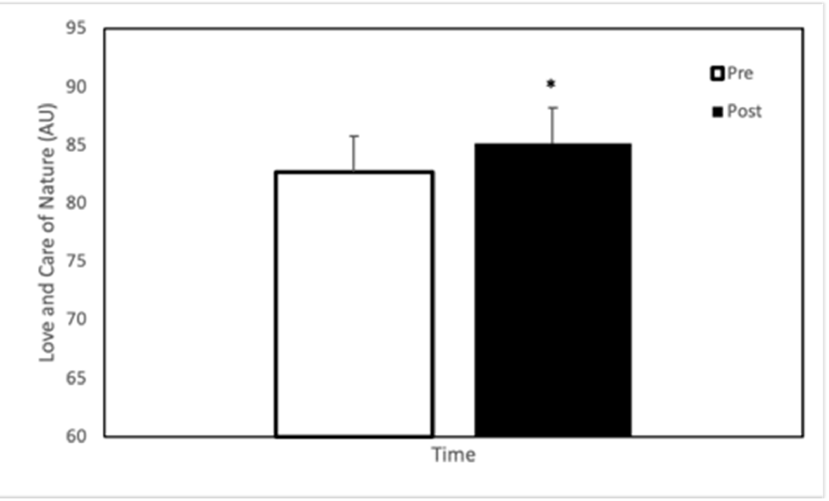
Figure 2. Love and Care of Nature scale (expressed as arbitrary units) in participants ( n = 20) at baseline and following a 0.8 km (0.5 mi) hike. * represents significant difference ( p < 0.05).